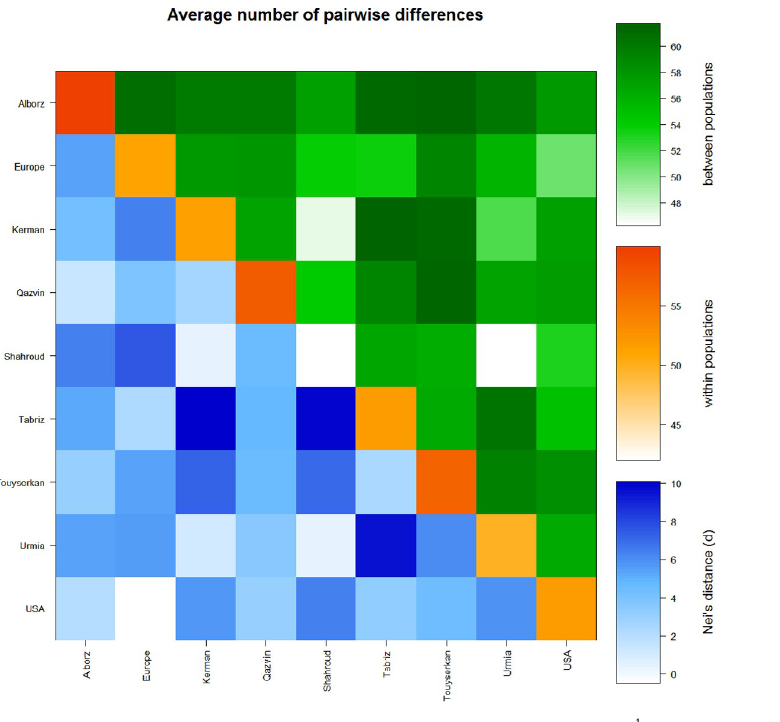
Fig 2. Nei’s genetic distance coefficient for the nine walnut